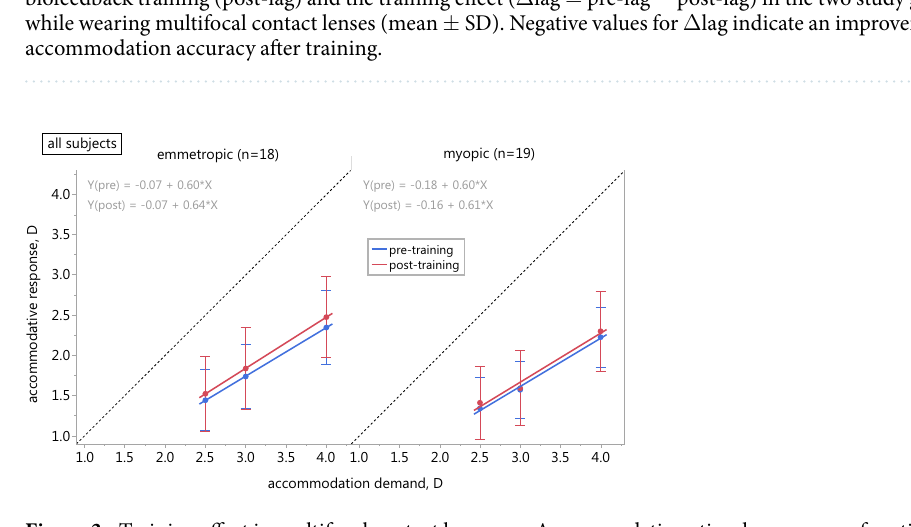
Figure 3. Training effect in multifocal contact lens wear. Accommodation stimulus-response functions of both study groups (emmetropes left, myopes right) with multifocal contact lenses. Error bars denote SD of the mean; the dashed line has a slope of